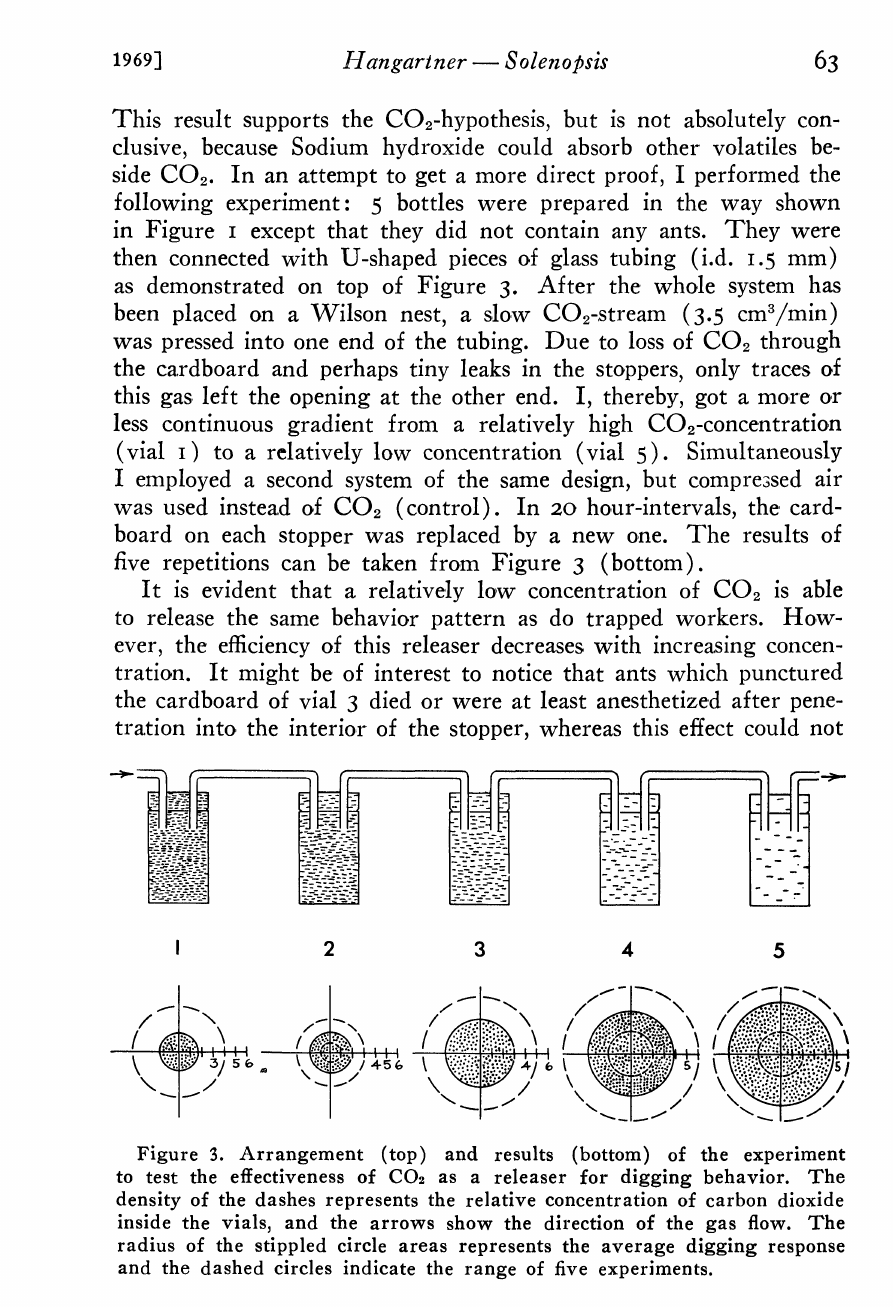
Figure 3. Arrangement (top) and results (bottom) of the experiment to test the effectiveness of CO2 as a releaser for digging behavior. The density of the dashes represents the relative concentration of carbon dioxide inside the vials, and the arrows show the direction of the gas flow. The radius of the stippled circle areas represents the average digging response and the dashed circles indicate the range of five